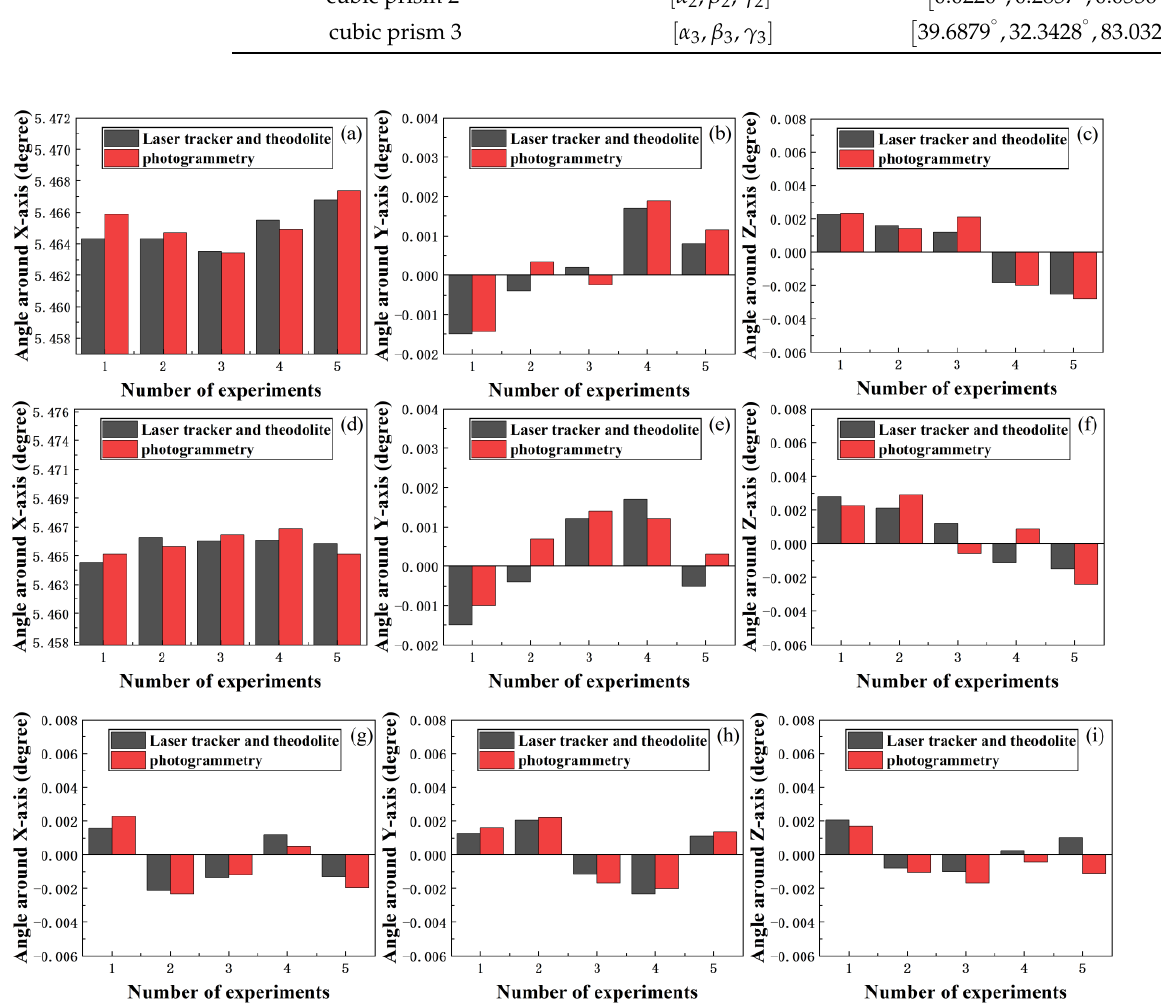
Figure 16. The rotation angles of the truss structure in XYZ directions are measured by two kinds of instruments: ( a – c ) corresponds to (1); ( d – f ) corresponds to (2); ( g – i ) corresponds to (3).